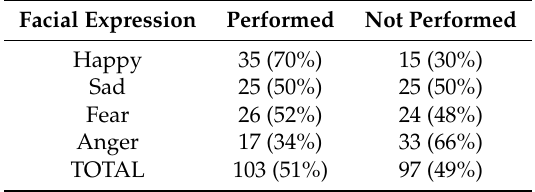
Table 6. Overview of the annotations carried out by the team of experts for TD children. Facial Expression